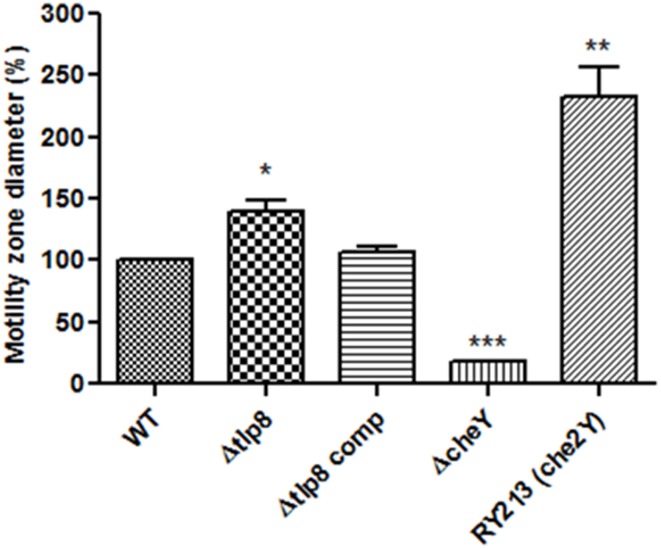
Role of chemoreceptors in motility. Histogram showing the diameter of the zone of motility expressed in percentages relative to the WT. The zone of motility was determined after stabbing 2 μL of C. jejuni (OD600 of 0.05) in the middle of a semi-solid (0.4%) MH agar plate. The agar plates were incubated microaerobically for 48 h and motility was assessed by measuring the diameter of the zone of motility. The Δtlp8 mutant showed increased motility. Motility was restored to values similar to the WT levels in the complemented strain. A C. jejuni 81-176 cheY mutant and the RY213 strain (diploid for cheY) were used as controls. *P < 0.05, **P < 0.01, ***P < 0.001.